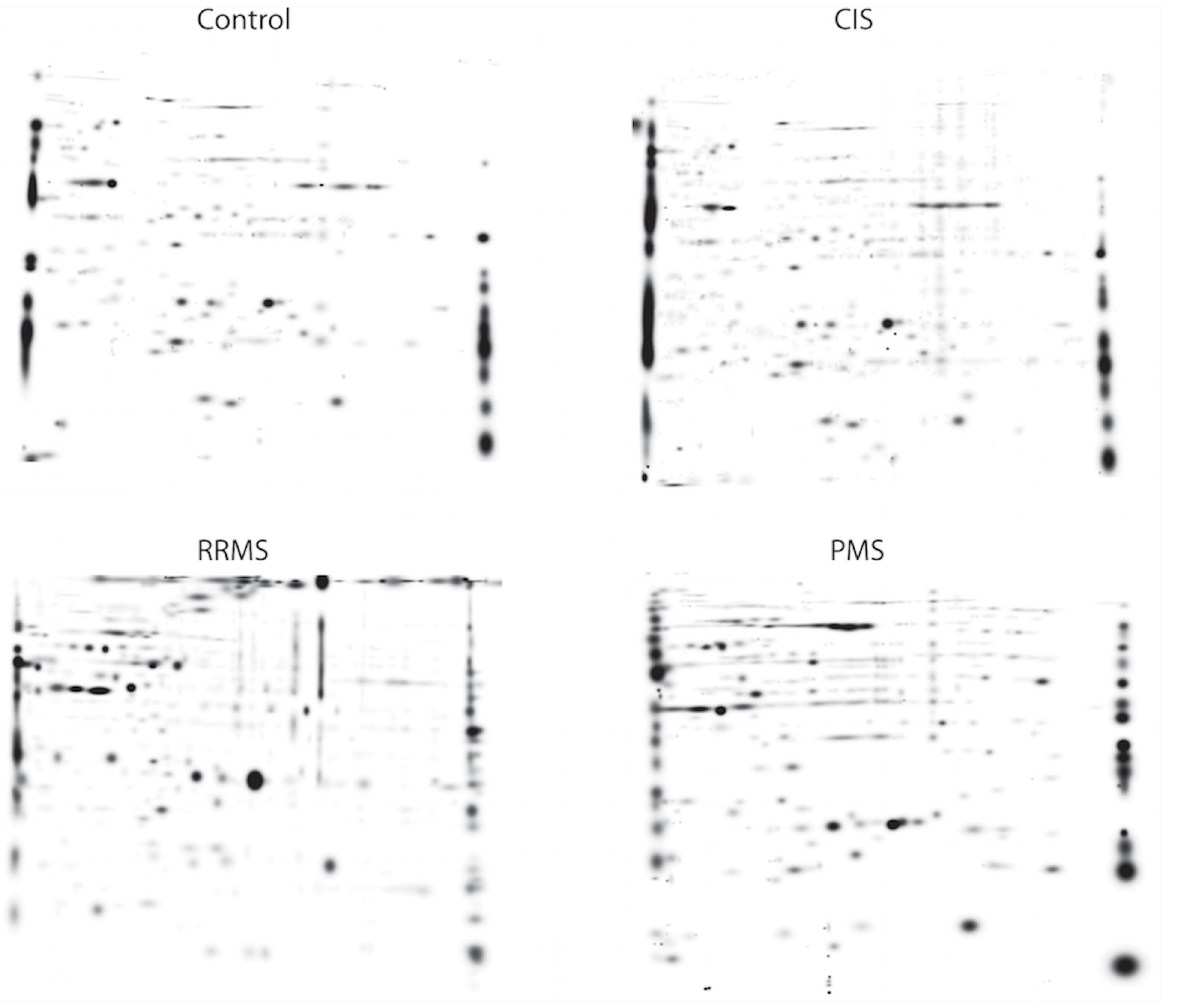
Fig 2. Representative 2D-PAGE image of each study group including control, CIS, RRMS and